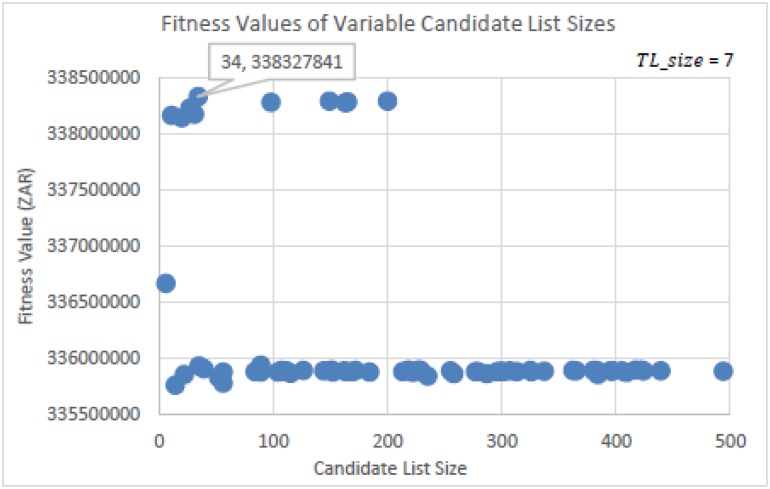
Zoomed in image of Fig 9.